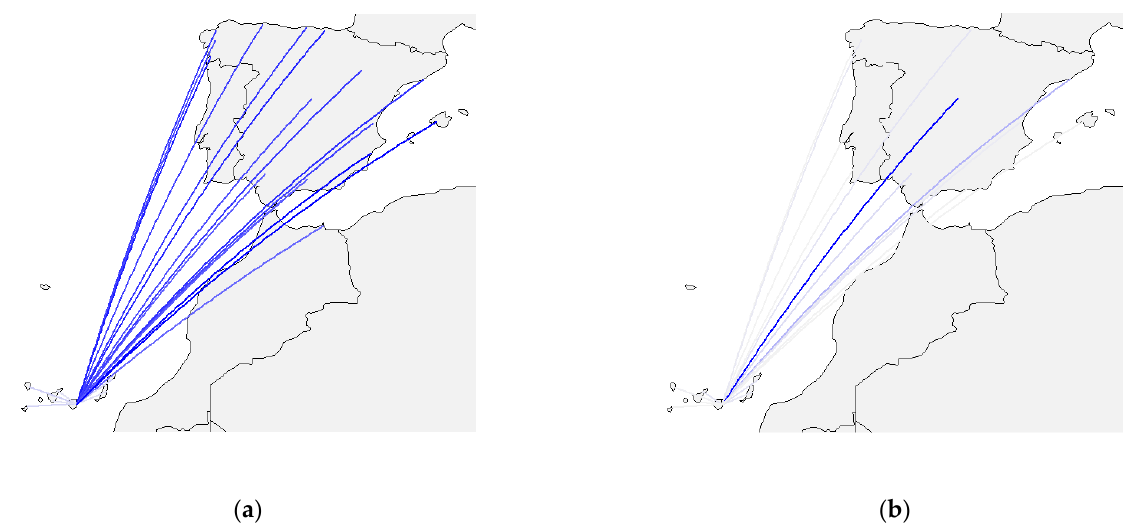
Figure 8. Carbon dioxide emissions from main domestic corridors operating in LPA airport, where a rough sketch means more emissions than the thinner one as follows: ( a ) Partial emission per passenger and route (arithmetic average: 112.43, standard deviation: 65.99); ( b ) Total emission of routes concerned. Source: own elaboration from the data provided by [19,20].